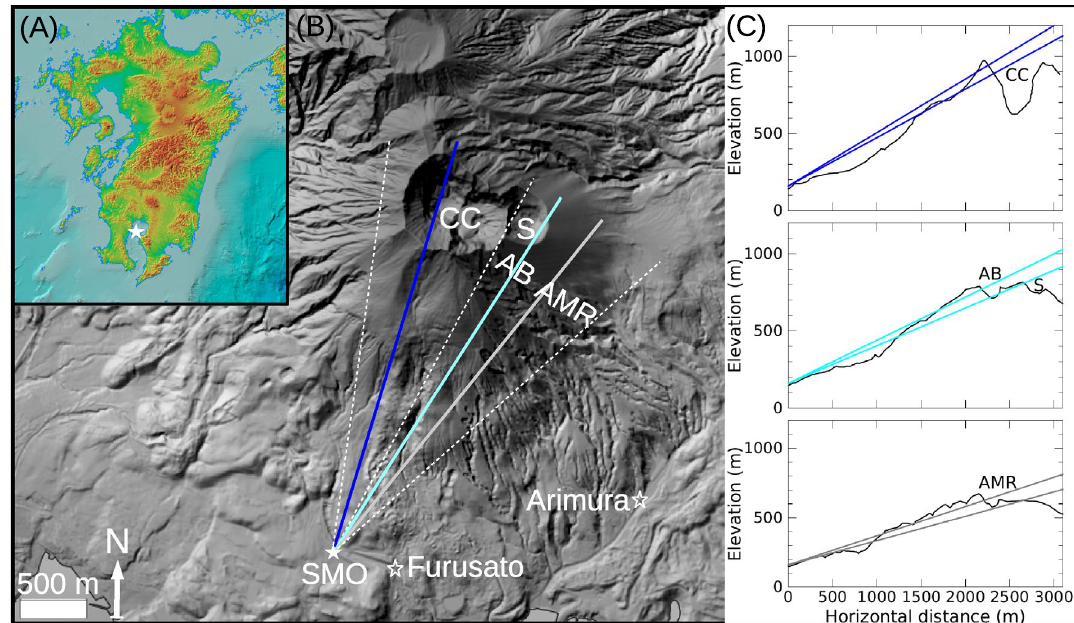
Figure 1. The map of the measurement site and the schematic drawing of the experimental arrangement. ( A ) The map of Kyushu, Japan is shown with the location of Sakurajima volcano (white star) 44 . ( B ) The elevation map of Sakurajima volcano is shown based on the data of Geospatial Information Authority of Japan 44 . The location of Sakurajima Muography Observatory (SMO) is shown by a filled white star. The dashed white lines show the orientation and angle of view of SMO. The coloured solid lines show selected cross-sections across the Central Craters (CC), Showa Crater (S) and Arimura Basis (AB), and Arimura Middle Reaches (AMR), respectively. The locations of lahar observation stations are shown by empty white stars. ( C ) The selected cross-sections of Sakurajima volcano are shown across the blue-coloured, cyan-coloured and gray-coloured lines of ( B ). The coloured lines indicate three selected angular regions in the vertical direction for muographic observation of the volcanic edifice.